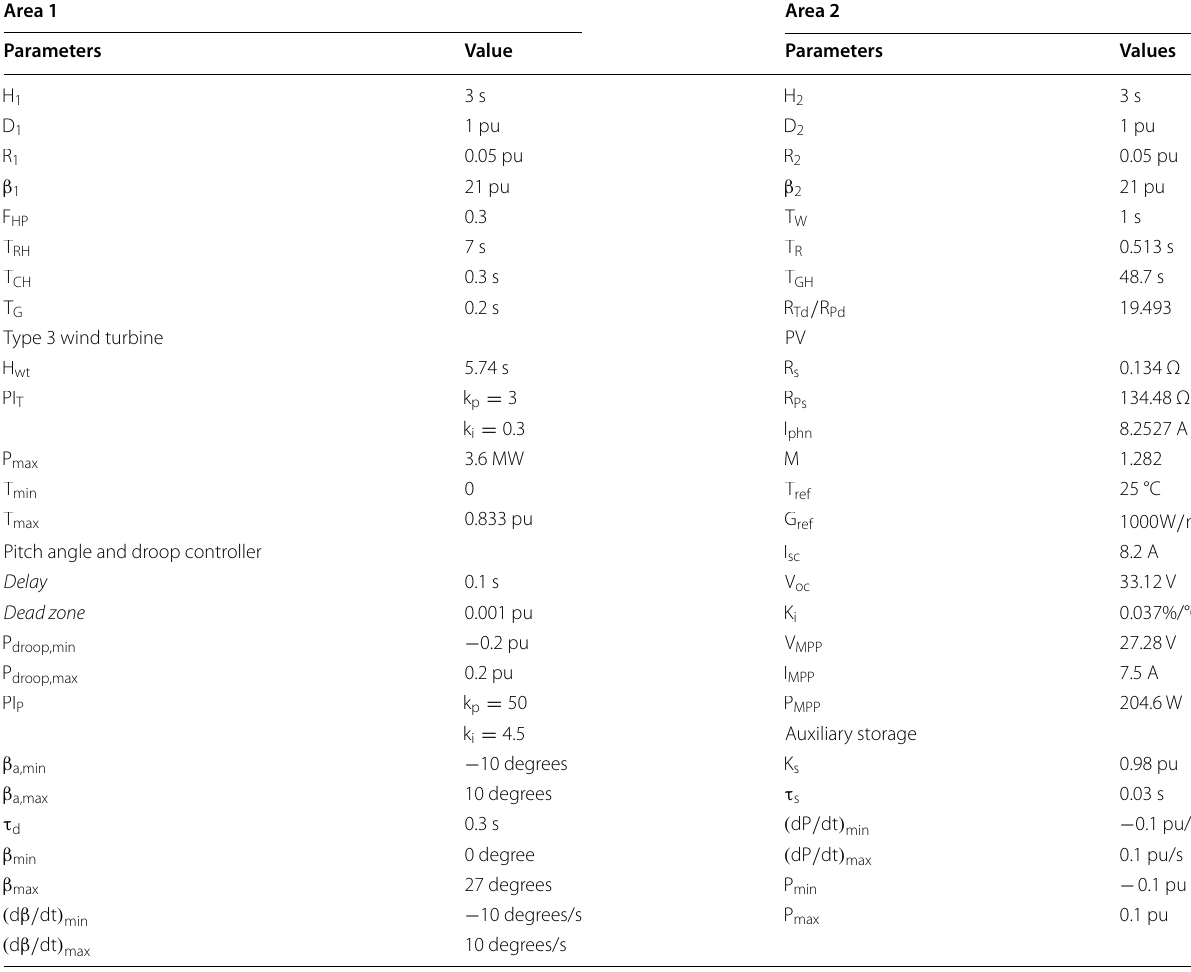
Table 1 Parameters of the proposed two‑area power system